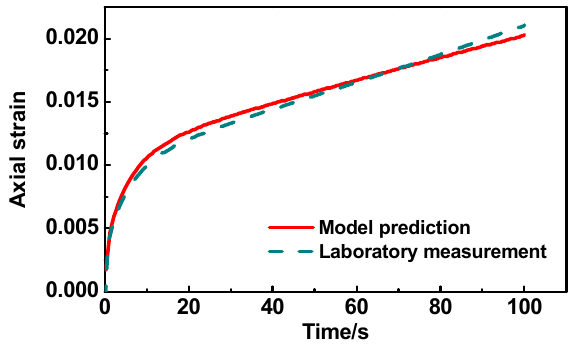
Figure 9. Results of discrete element model (DEM) prediction and laboratory measurement.